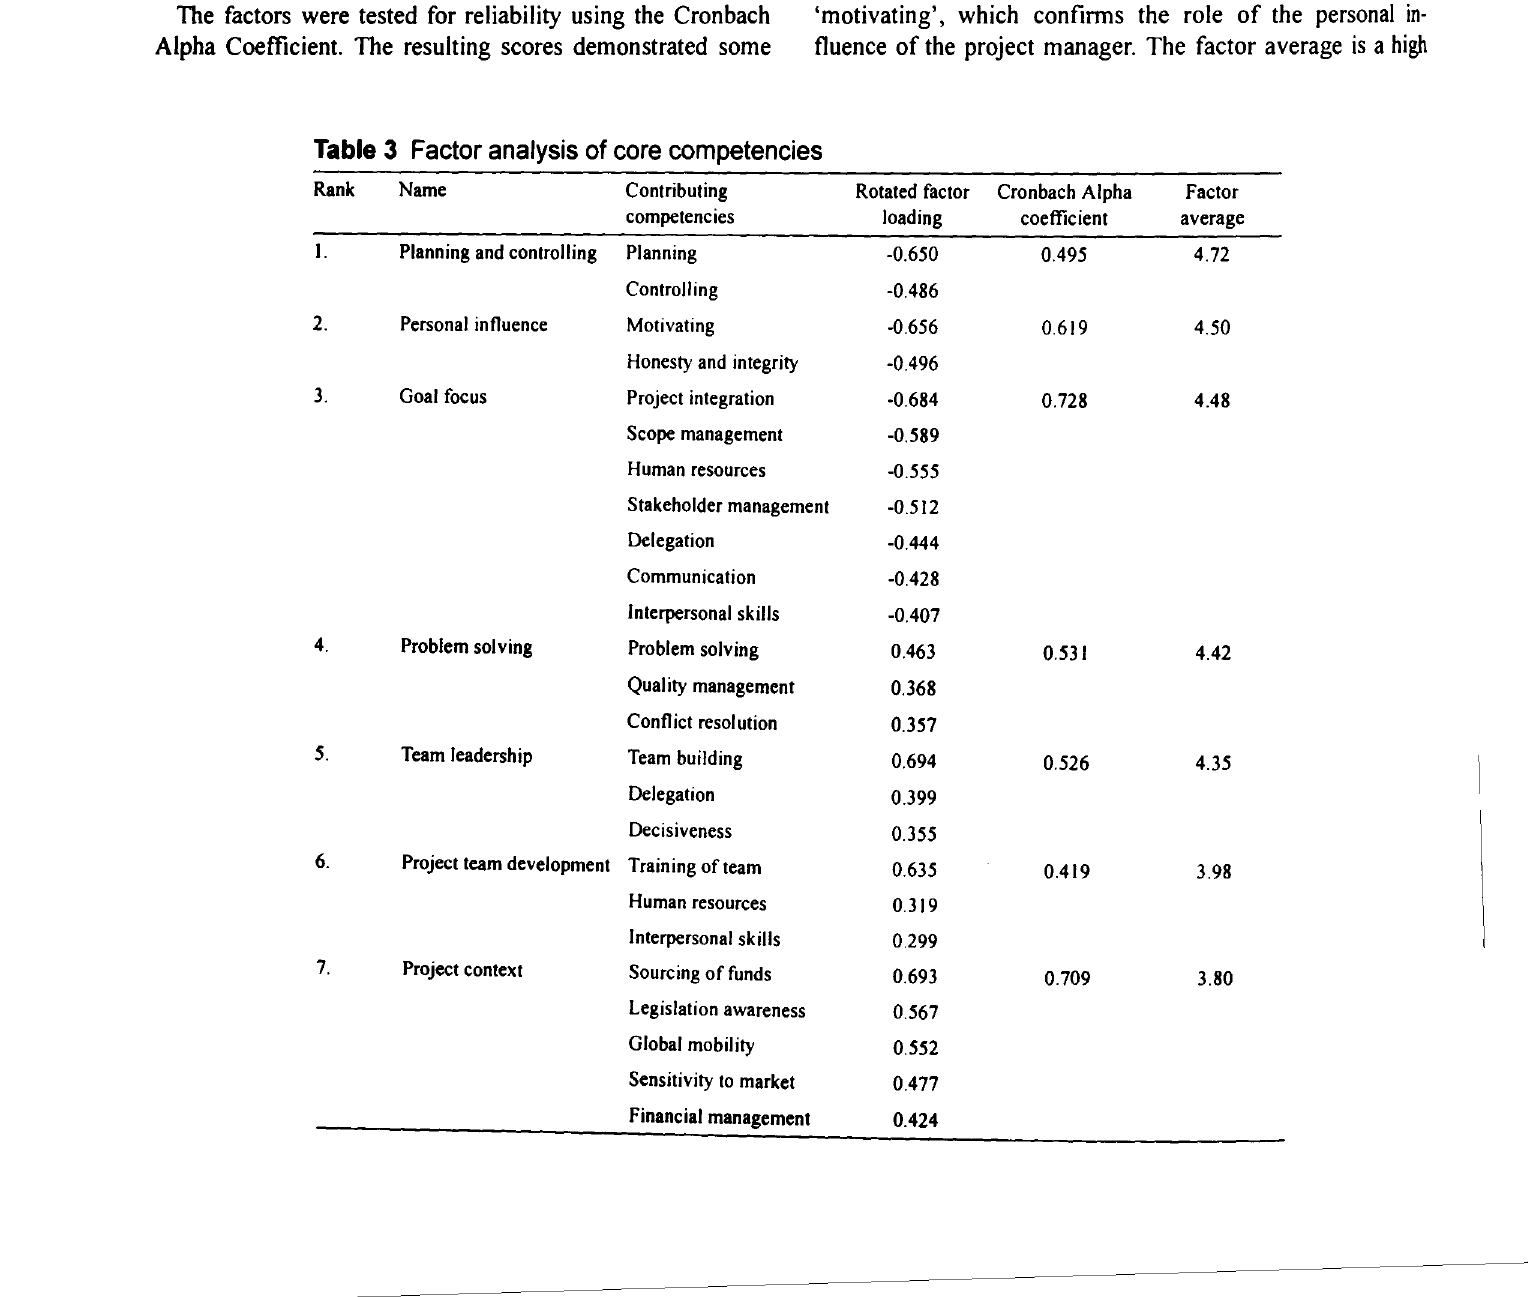
Table 3 Factor analysis of core